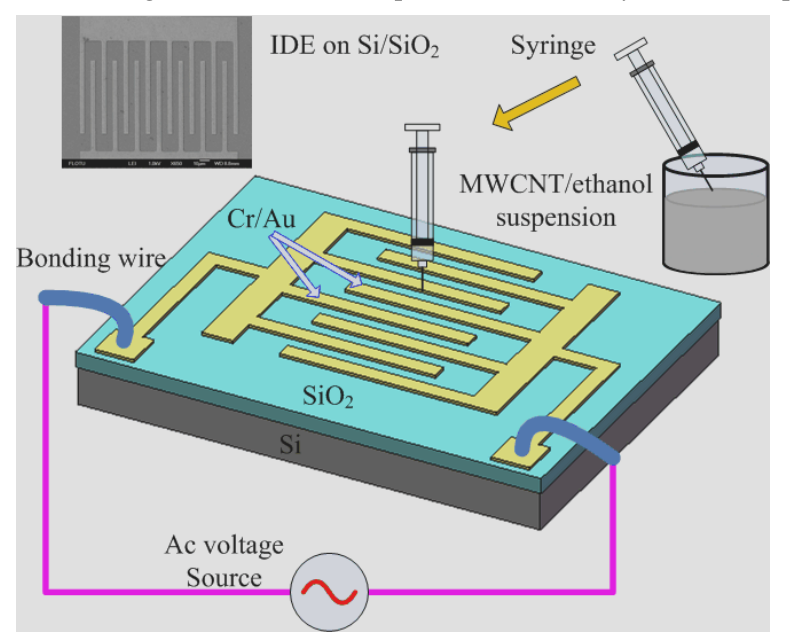
Figure 1. Schematic diagram of MWCNT deposition on IDEs by ac